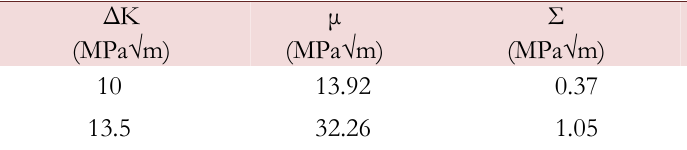
Table 10: Estimated crack growth rates: means and standard